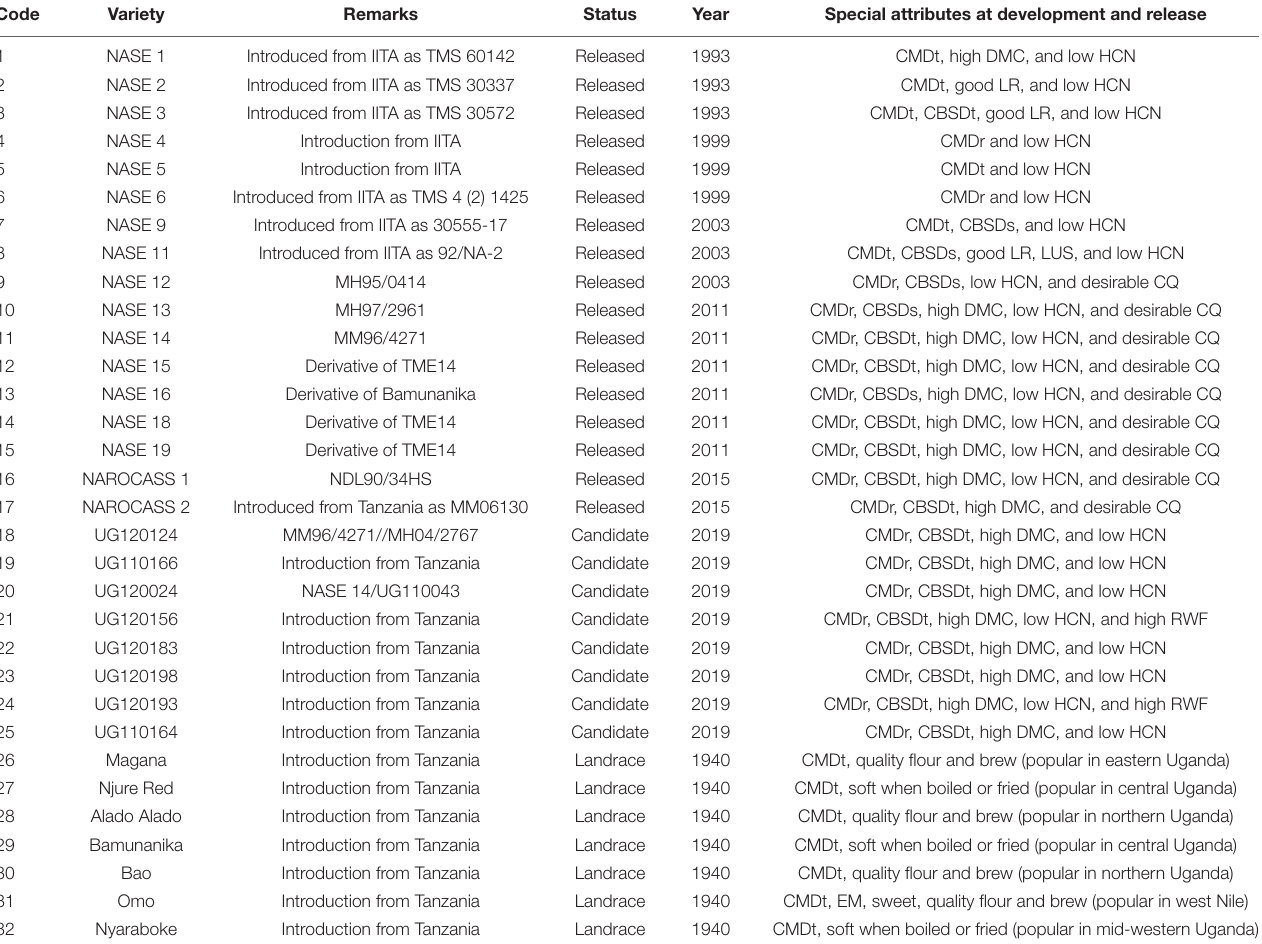
TABLE 1 | Summary of attributes and origin of varieties used for genetic gain assessment.